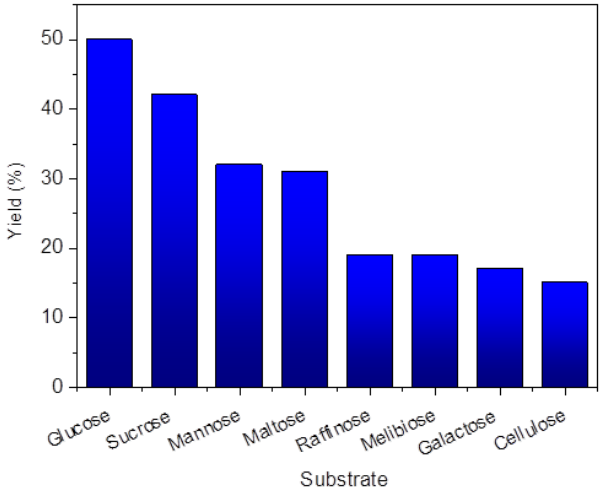
Figure 4. Evaluation of different carbohydrates.